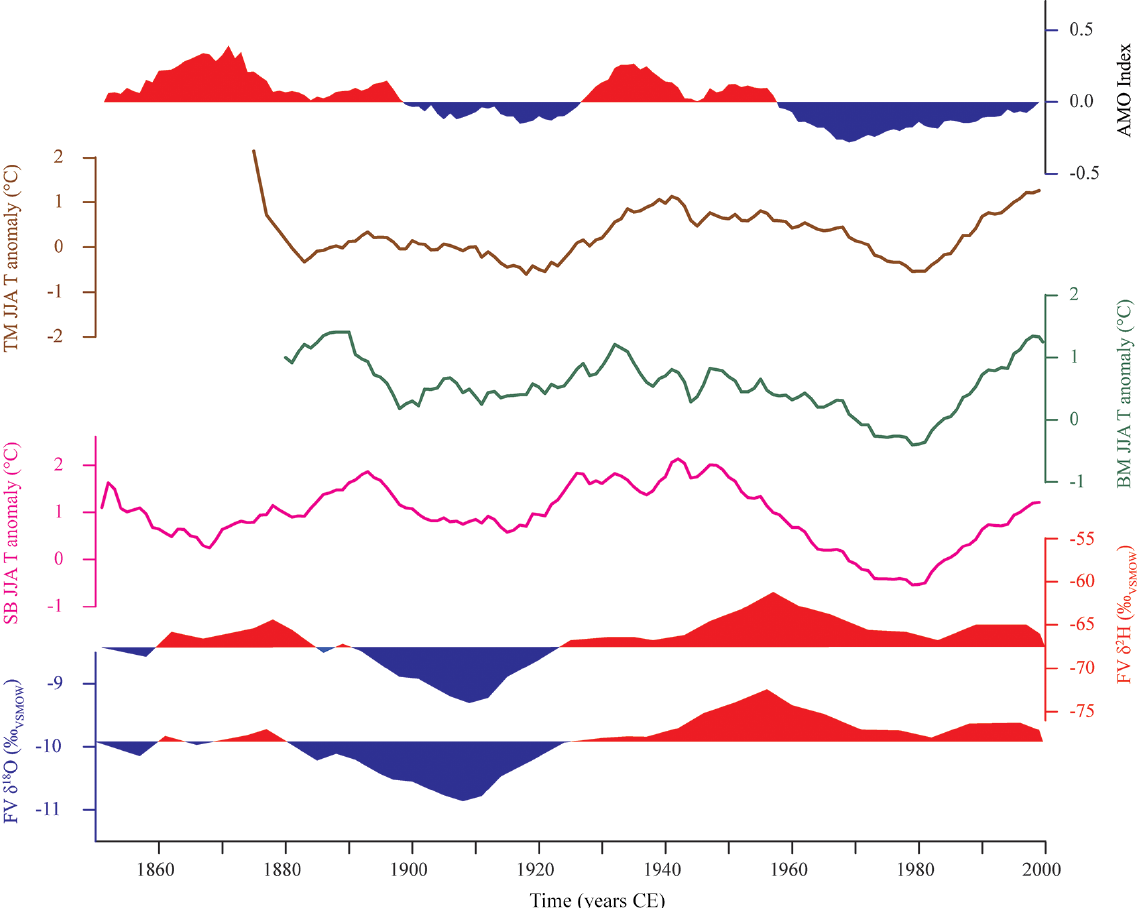
Figure 4. Temporal variability of the Atlantic Multidecadal Oscillation instrumental index; summer (JJA) air temperature (anomalies with respect to the 1961–1990CE period) recorded at the Baia Mare (BM), Timis , oara (TM) and Sibiu (SB) weather stations; and FV δ 18 O and δ 2 H (‰) during the instrumental period. In the lower panels, the positive (red) and negative (blue) anomalies are shown against the 1850–2000CE averages for the FV δ